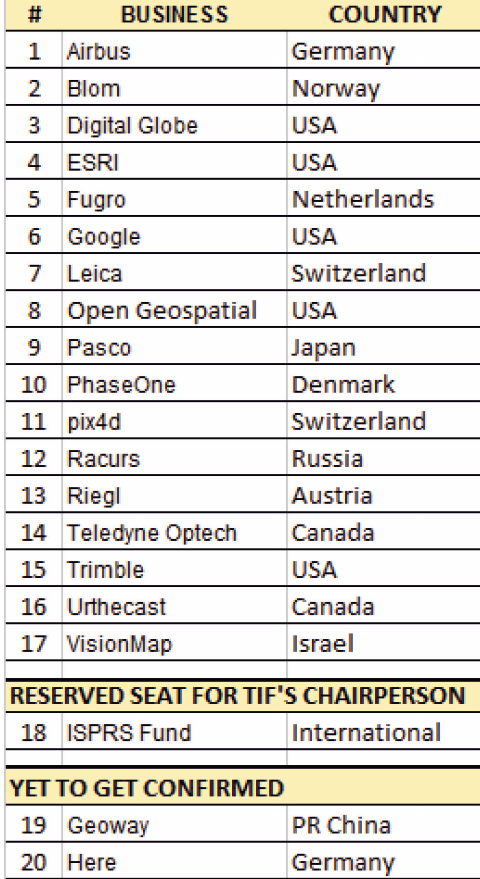
Table 5: Entities who have received an invitation to assume one of the 20 seats on I2AC. 17 businesses had accepted the invitation at the time of this writing. Note that the organizer/reporter is not counted as a